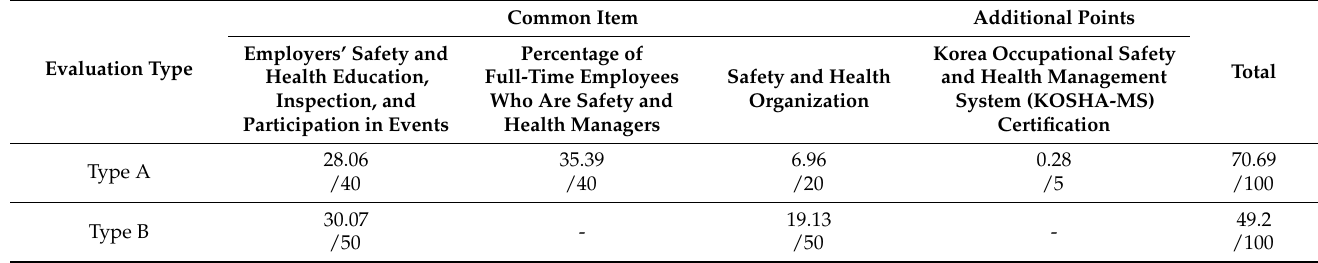
Table 5. Average points for each evaluation item according to